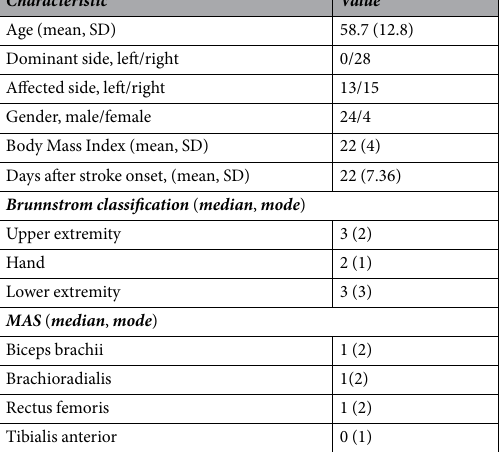
Table 1. Demographics data of all participants. Keys: SD – standard deviation; MAS – modified Ashworth scale. Relative reliability